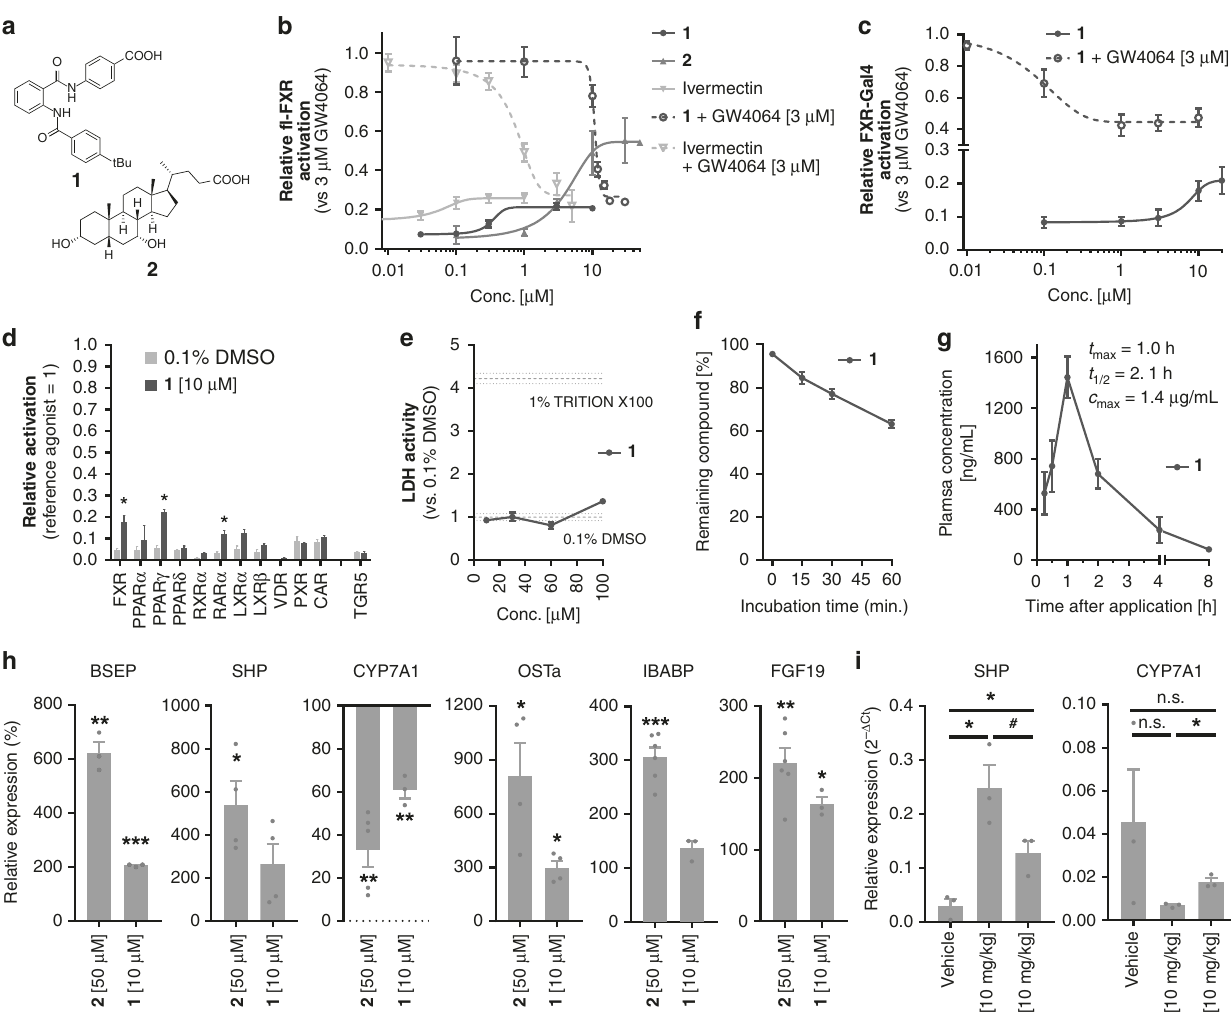
Fig. 1 Structure and pharmacological pro fi le of partial FXR agonist 1 . a Constitution of 1 and endogenous agonist CDCA ( 2 ). b Dose-response curves of partial agonist 1 , endogenous agonist 2 and ivermectin in a BSEP response element driven full-length FXR reporter gene assay. 1 partially activates FXR with an EC 50 value of 0.35 ± 0.06 µ M and 21.1 ± 0.5% relative ef fi cacy compared to the synthetic agonist GW4064 (3 µ M). 1 also partially represses GW4064- induced FXR activation with an IC 50 value of 10.9 ± 0.2 µ M to 26 ± 2% relative activation. CDCA ( 2 ) behaves as weakly potent (EC 50 = 4.0 ± 0.2 µ M) agonist. Ivermectin has partial FXR agonistic activity (EC 50 = 0.060 ± 0.007 µ M, 26 ± 1% rel. activation) and suppresses GW4064-induced FXR activation (IC 50 = 0.80 ± 0.16 µ M, 22 ± 6% rel. act.). Results are mean ± SD, n = 3. c Partial agonistic activity of 1 was also observed in a hybrid Gal4-FXR reporter gene assay. d Pro fi ling of 1 on NRs in hybrid reporter gene assays. Results are mean ± SEM, n = 3. e In vitro toxicity of 1 in HepG2 cells: 1 exhibits no acute toxicity in vitro up to 100 µ M concentration. Results are mean ± SEM, n = 4. f In vitro metabolism analysis: 1 comprises good stability versus microsomal degradation with >60% of the parent compound remaining after 60 min. incubation. Results are mean ± SEM, n = 4. g Pharmacokinetic pro fi le of 1 in